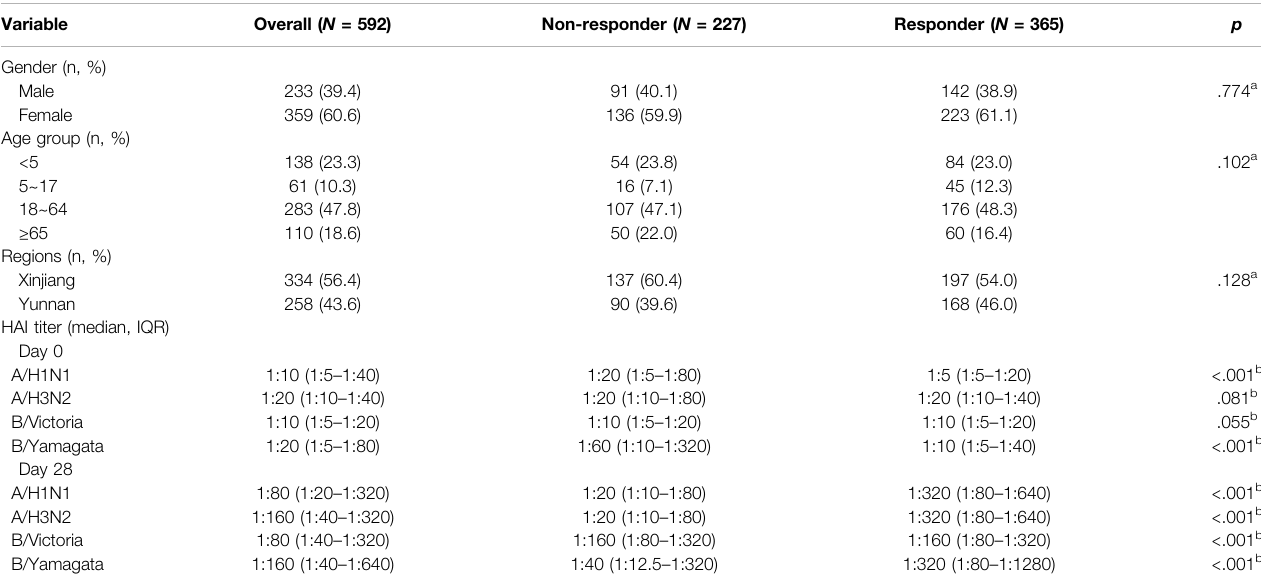
TABLE 1 | Demographic characteristics and HAI antibody titers of the study